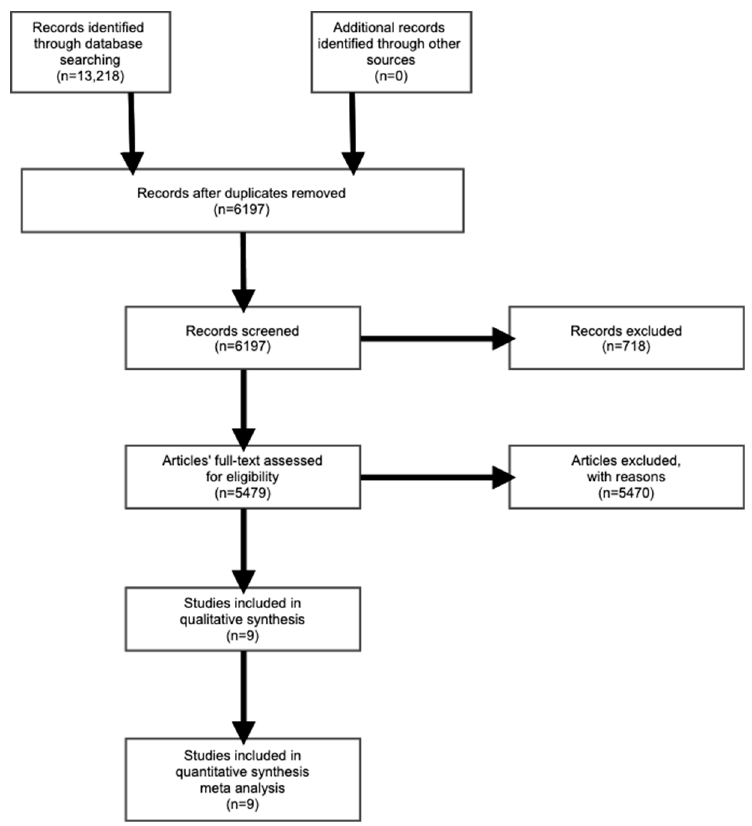
Figure 1. PRISMA flow diagram of identification and inclusion of papers.